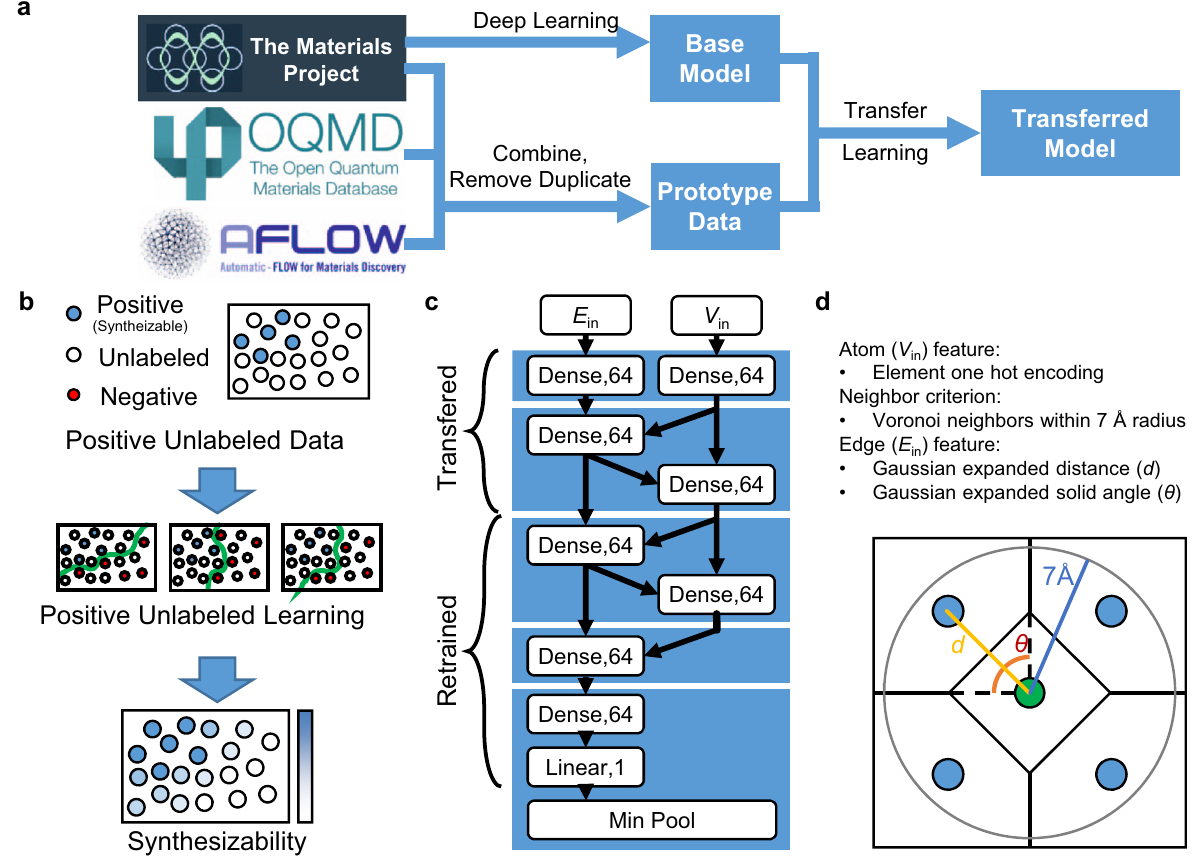
Fig. 1 Overview of the model development. a Domain-speci fi c transfer learning work fl ow. The model is fi rst trained with the Materials Project database, and the model is re-trained with the perovskite-only data extracted from the three databases. b Positive and unlabeled learning procedure overview. c The graph neural network architecture. E in and V in are the atom and edge features. Dense indicates the linear multiplication followed by the softplus activation layer and Linear indicates linear multiplication. The number next to the operation indicates the output feature dimension. Min Pool indicates minimum pooling followed by sigmoid activation. More detail is in the “ Methods ” section. d The crystal representation. Atoms and edges are converted to mathematical representation via